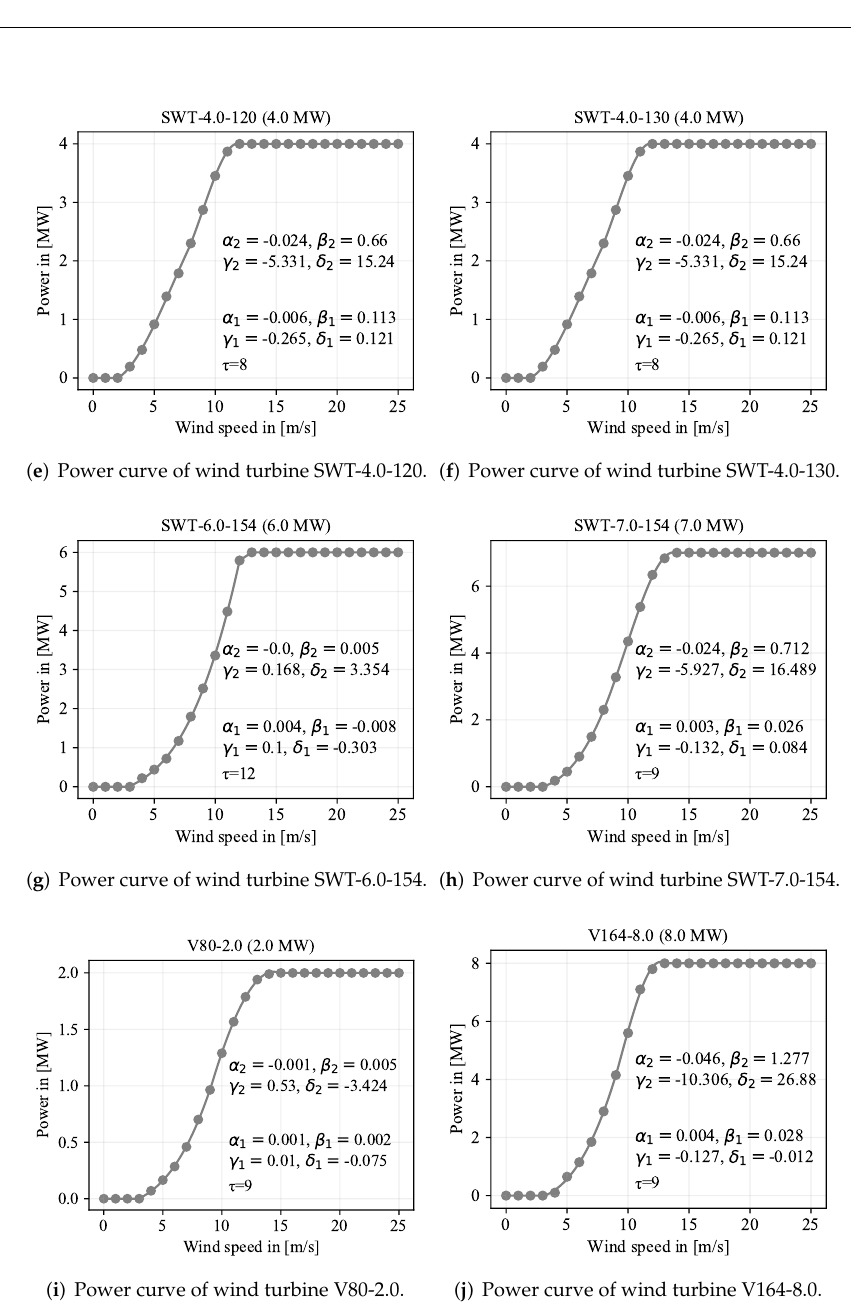
( i ) Power curve of wind turbine V80-2.0. ( j ) Power curve of wind turbine V164-8.0.